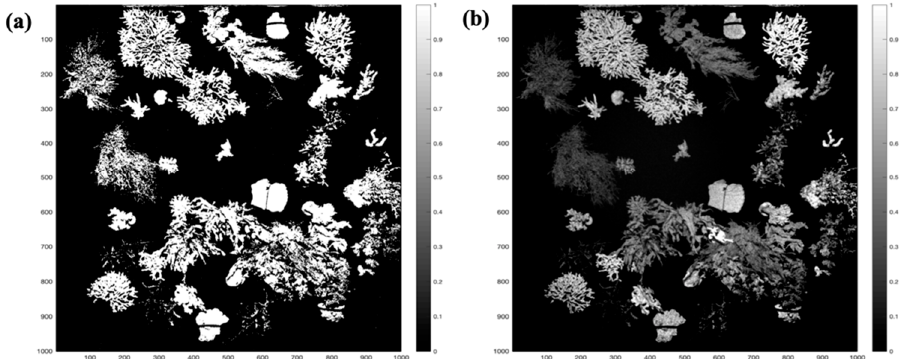
Figure 8. Fluorescent substrate pixel isolation and extraction from background non-fluorescent pixels via thresholding: ( a ) Left: A composite of fluorescence at 685 nm is used here to create a binary mask to select green + brown macroalgae, 580 nm for red macroalgae, and 520 nm for coral (but other wavelengths also can identify “coral” pixels); ( b ) Right: Fluorescent pixel image obtained from extracting 685 nm fluorescent pixels from non-fluorescing background pixels via thresholding.